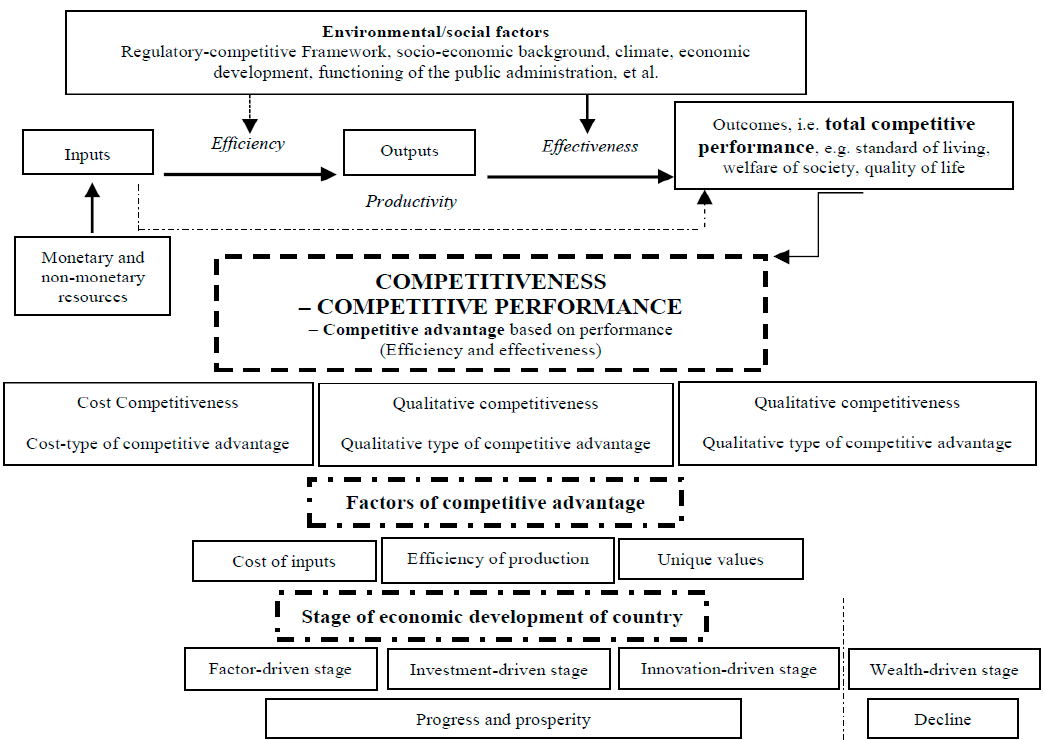
Figure 1. The relationship between the efficiency and the effectiveness impacting competitiveness (source: Mandl et al. 2008; own extension and elaboration).